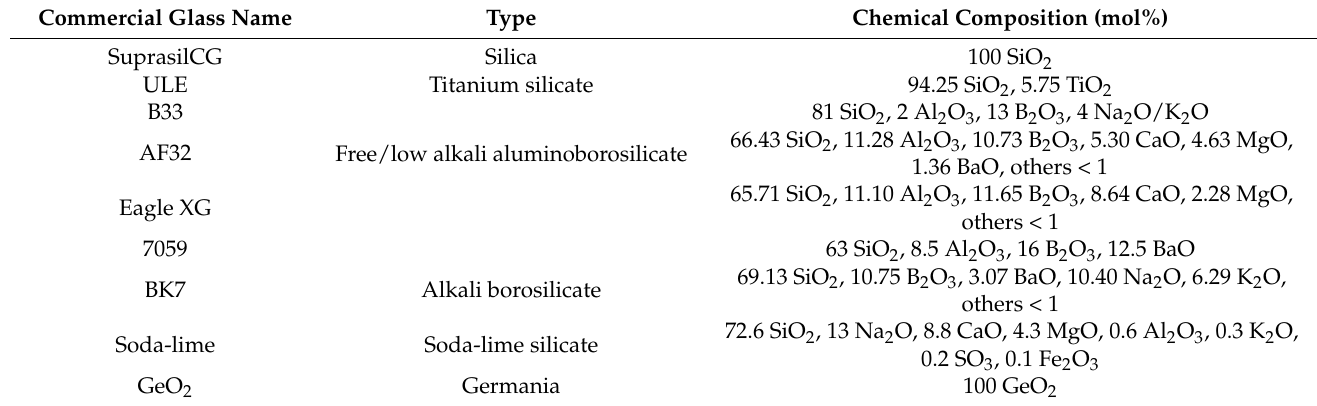
Table 1. Name, type, and chemical composition of all of the glasses